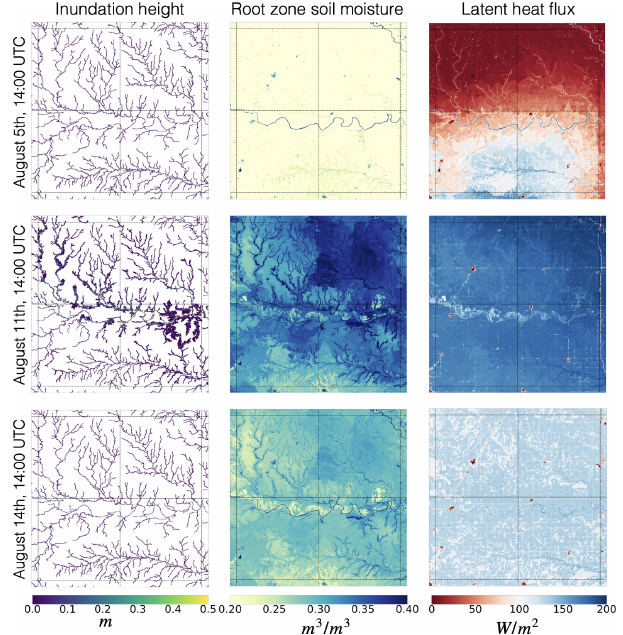
Figure 6. Mapped simulated inundation height, root zone soil mois- ture, and latent heat flux over the central four macroscale poly- gons in the study domain on three different time steps: 5 August 14:00UTC, 11 August 14:00UTC, and 14 August 14:00UTC. The chosen time steps coincide with the event shown in Fig. 5 and show the area before, during, and after the flood